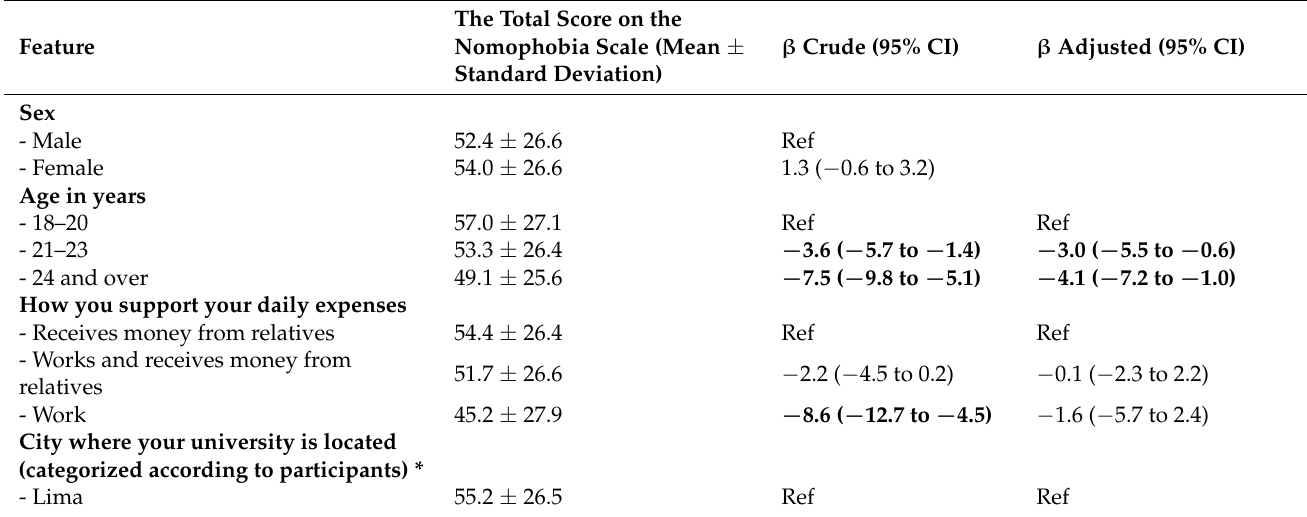
Table 3. Factors associated with nomophobia (NMP-Q score) in Peruvian medical students (n =